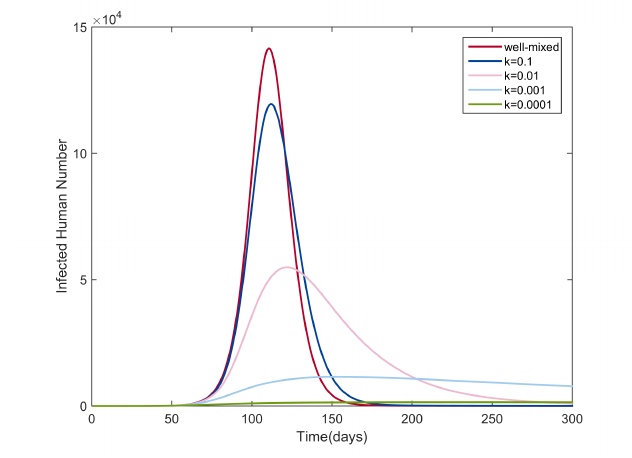
Figure 6. Infection curves for different values of k for the NBD SEIR-SEI model and the corresponding well-mixed